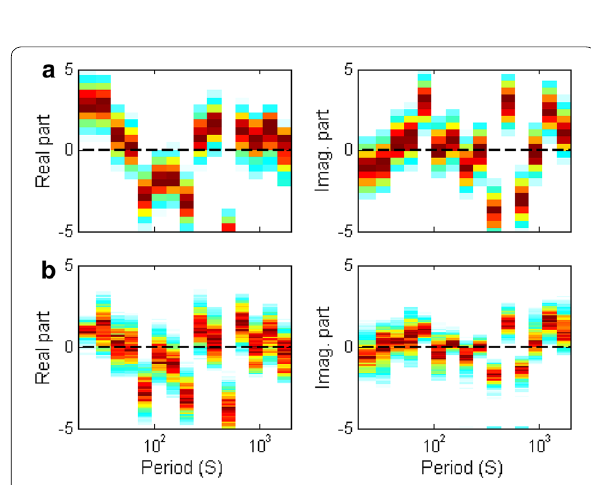
Fig. 8 Probability density plots of the posterior data residuals normalized by the sample standard deviations for the inversions ( a ) with and ( b ) without considering error